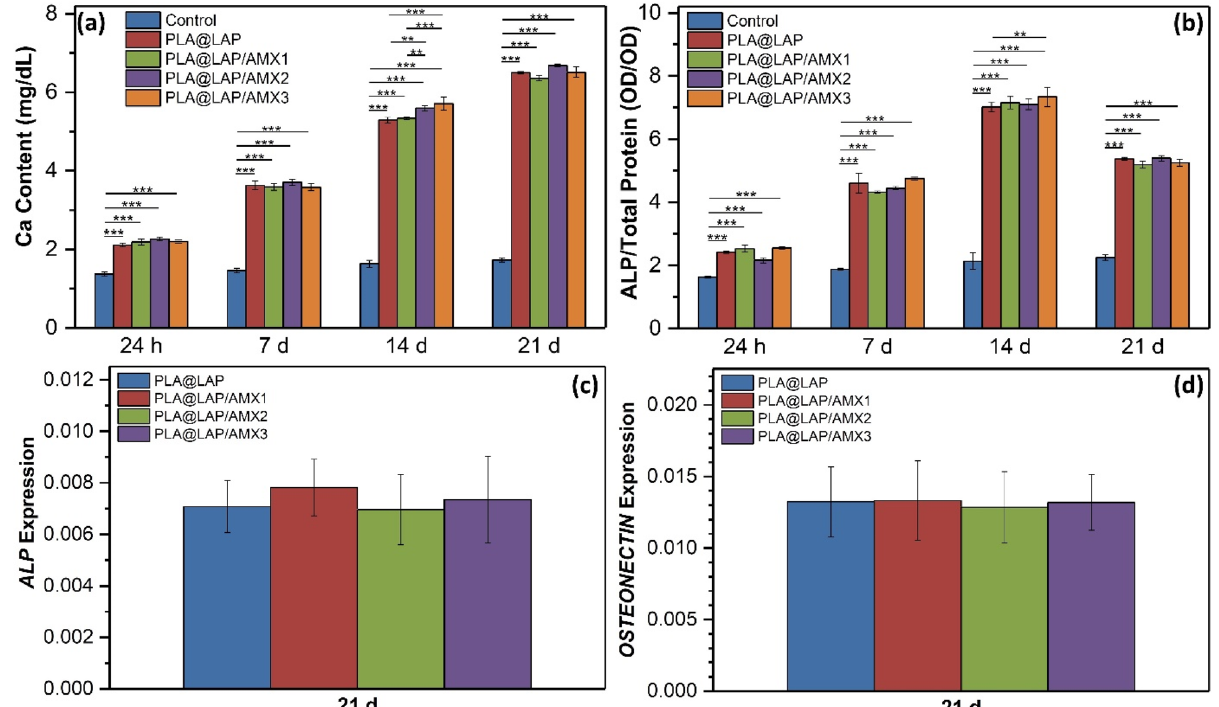
Figure 7. ( a ) Quantity of calcium deposited on the hBMSC-seeded scaffolds determined by calcium CPC kits (n = 3, *** p < 0.01, *** p < 0.001). Tissue culture plate was used as the control. ( b ) ALP activity of hBMSCs cultured on scaffolds (n = 3, *** p < 0.001). Expression of ALP ( c ) and OSTEONECTIN ( d ) markers in hBMSC cultured on scaffolds (n = 3, p >